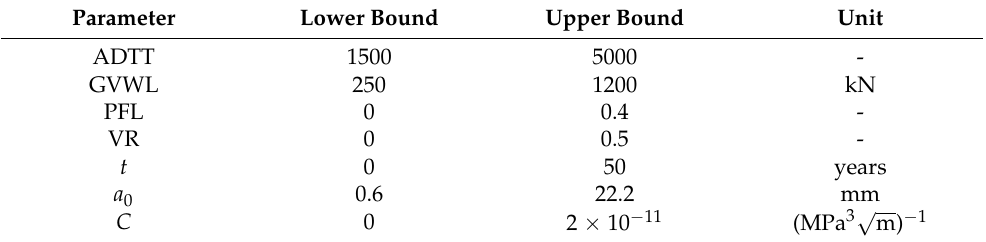
Table 3. Ranges of input parameters.